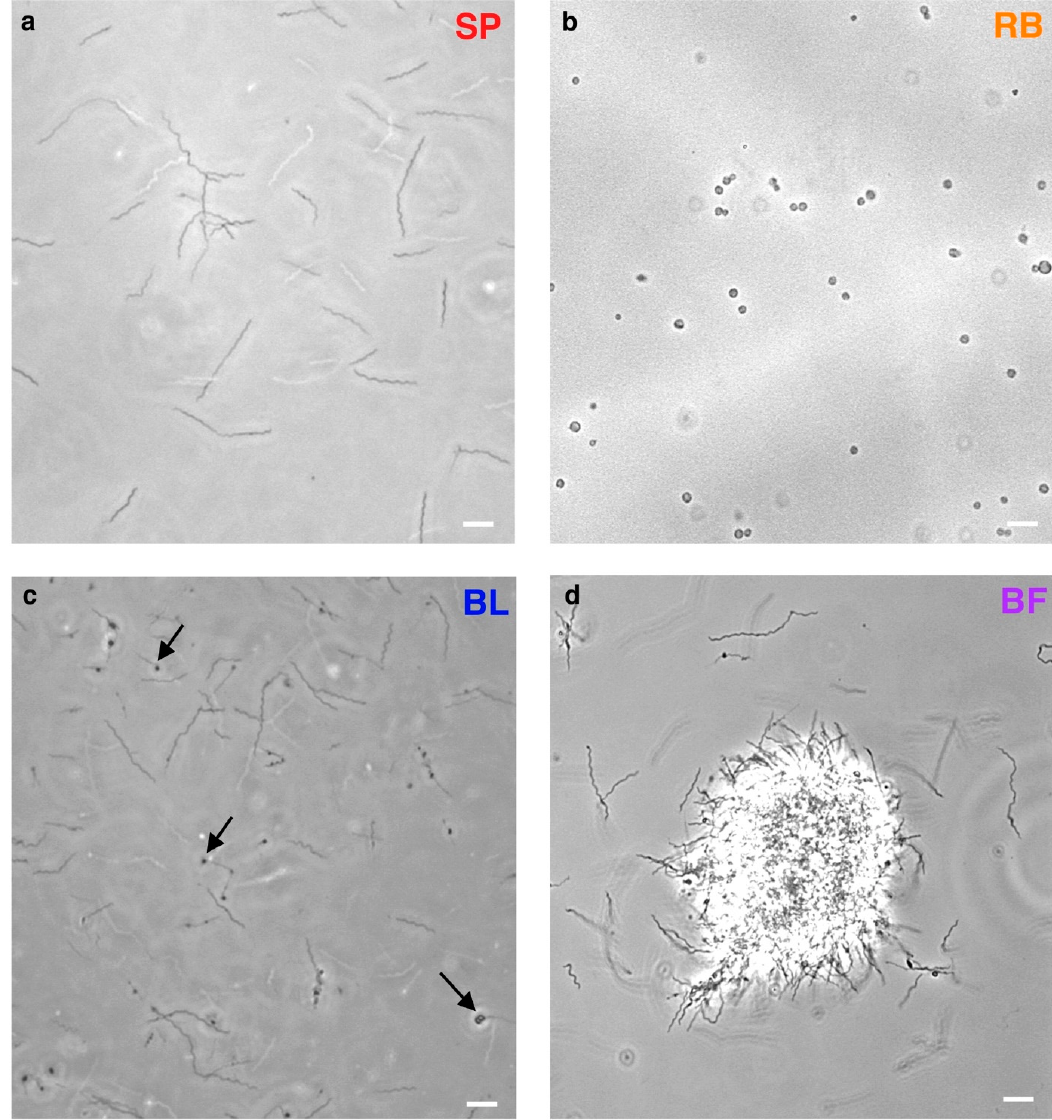
Figure 1. Representative images of B. burgdorferi B31 morphotypes. Phase contrast images of B. burgdorferi live cell cultures: ( a ) spirochetes (SP), ( b ) round bodies (RB), ( c ) blebs on spirochetes (BL) marked by black arrows and ( d) biofilm (BF). White bars—10 μ m (400× magnification).